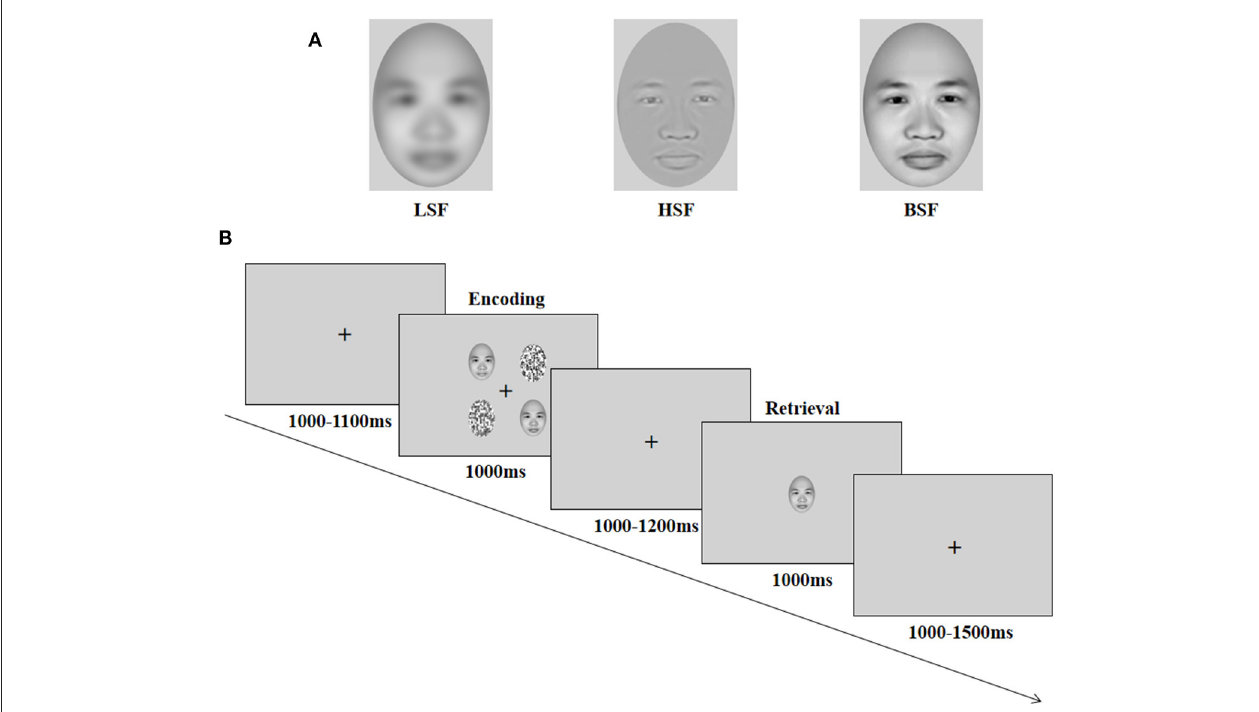
FIGURE 1 | Illustration of face stimuli (A) and procedure (B) . LSF = low spatial frequency; HSF = high spatial frequency; BSF = broadband spatial frequency. Reproduced with permission from Singular Inversions Inc., available at https://facegen.com.